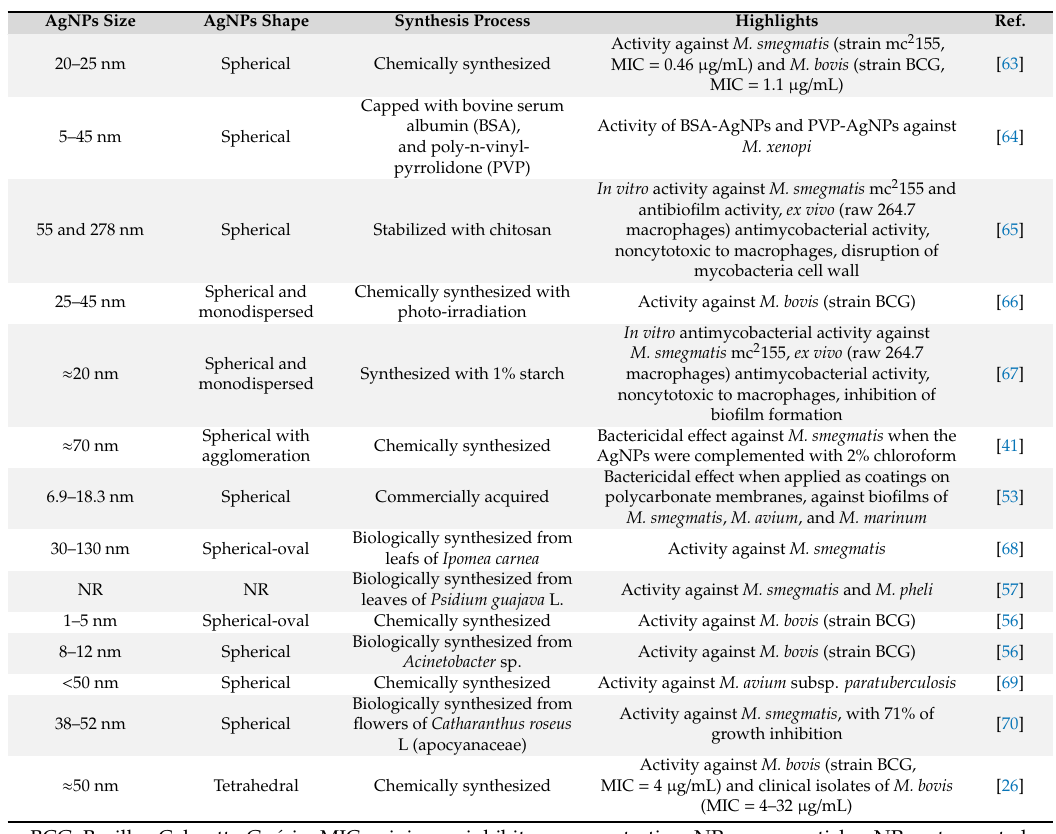
Table 1. AgNPs with reported activity against mycobacteria—excluding Mycobacterium tuberculosis .